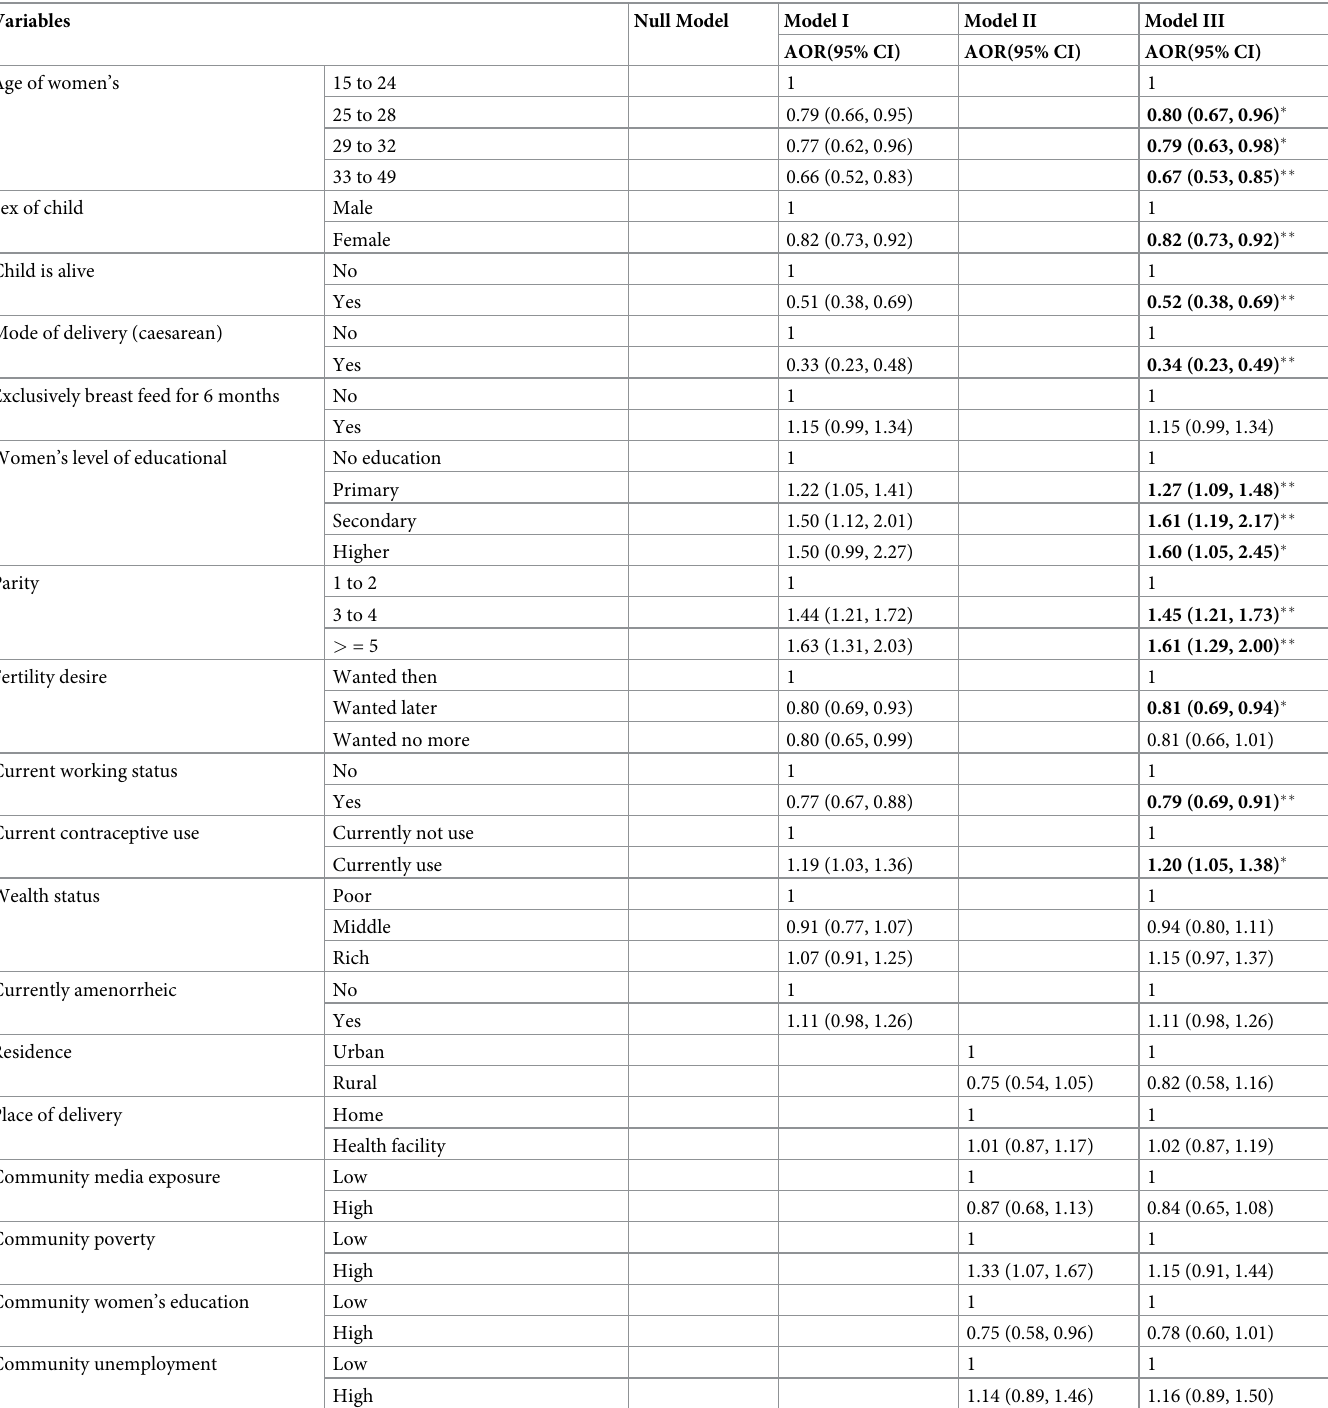
Table 4. Multilevel logistic regression analysis for the assessment of determinants of early resumption of post-partum sexual intercourse in Ethiopia, EDHS